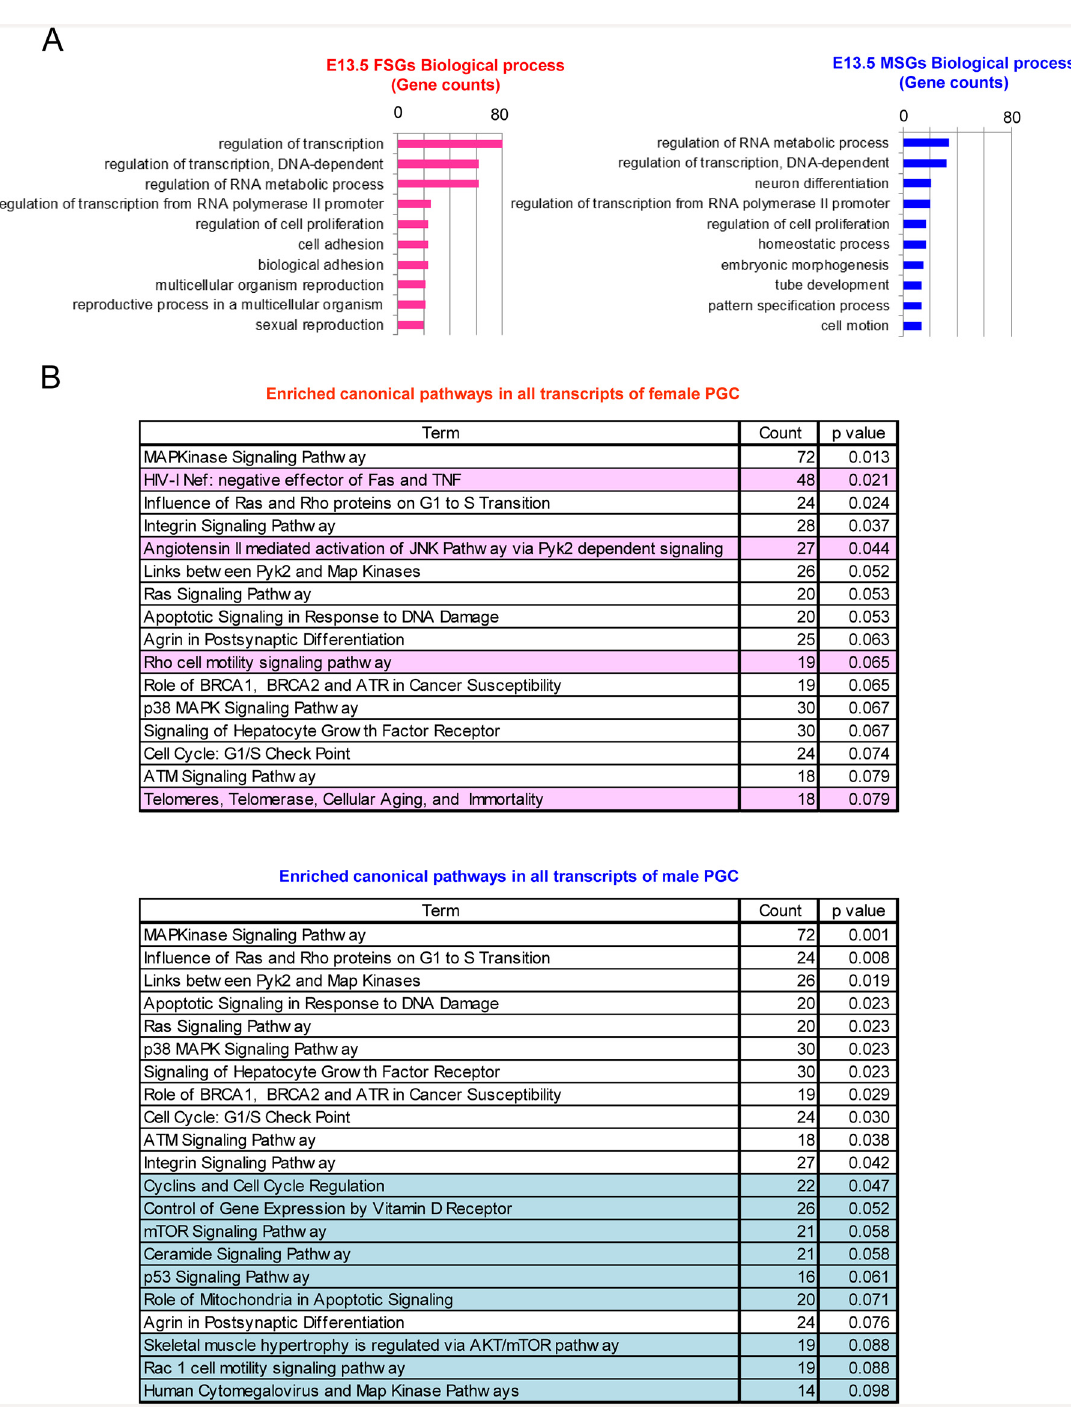
PLOS ONE | DOI:10.1371/journal.pone.0144836 December 23,